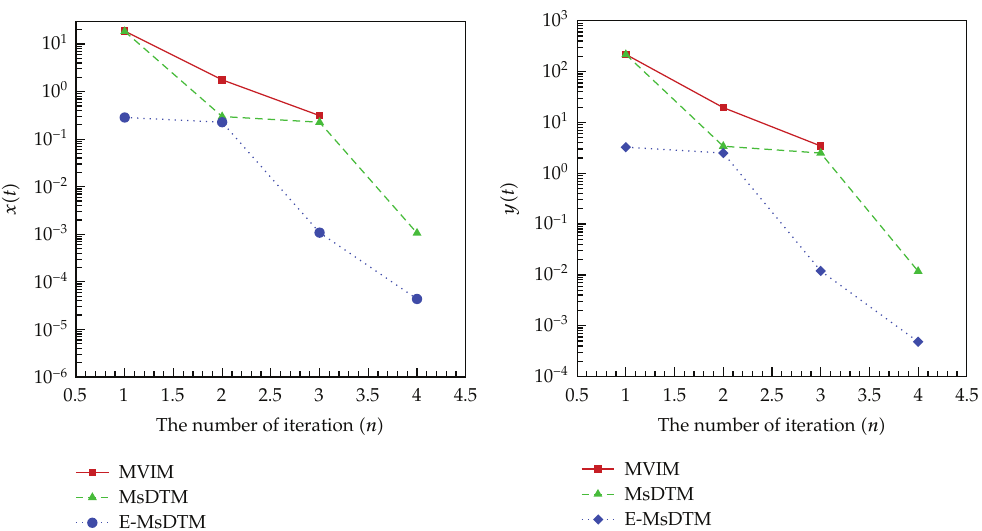
Figure 7: Maximum error with the number of iteration.